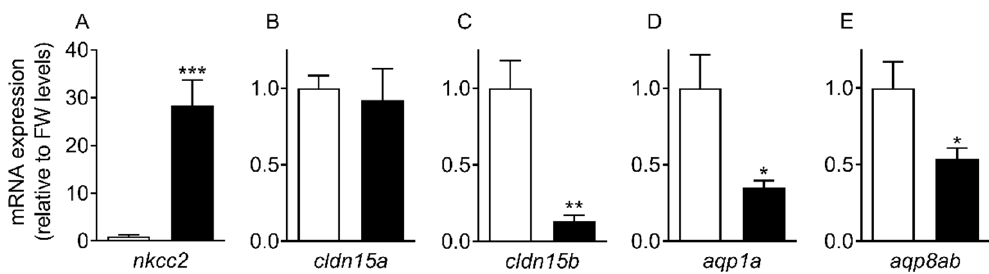
Figure 4. Transcript levels of nkcc2 ( A ), cldn15a ( B ), cldn15b ( C ), aqp1a ( D ), and aqp8ab ( E ) in intestine from medaka acclimated to FW (white bars) or SW (black bars). Fish were acclimated to the respective salinities for over one month prior to sampling ( n = 8). Expression levels represent the mean value ± SEM relative to FW levels. Asterisks indicate a significant difference from FW expression (* p < 0.05, ** p < 0.01, *** p < 0.001).